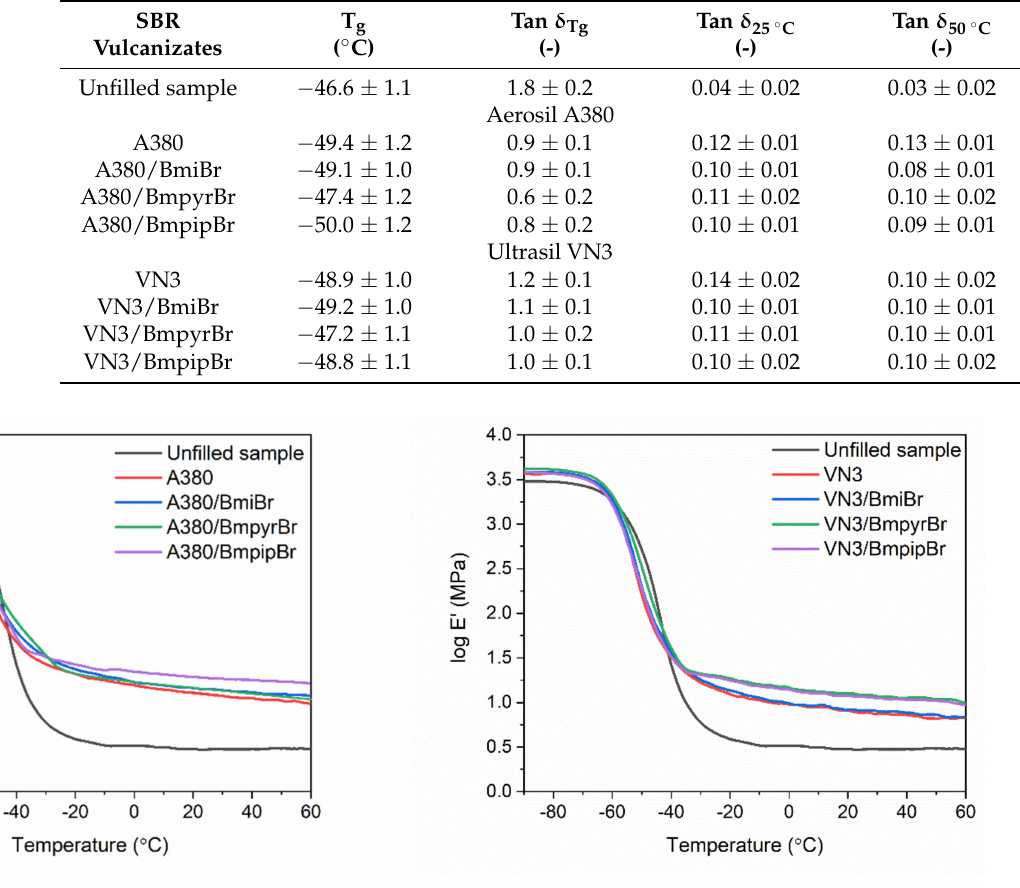
Table 9. Glass transition temperature (T g ) determined by dynamic mechanical analysis (DMA) and